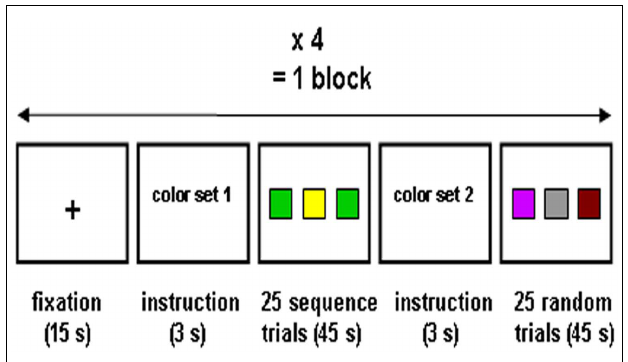
FIGURE 2 |The procedure of one scanning block included four repetitions of a fixation phase, an instruction phase, a sequence learning phase, an instruction phase and a random control phase. One scanning session comprised five